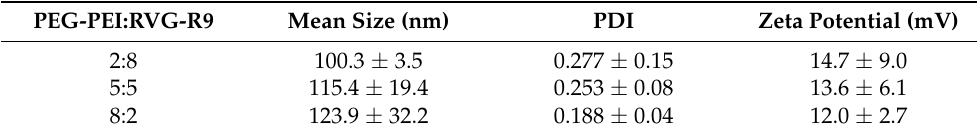
Table 2. Size and zeta potential of ternary complexes at the N/P ratio of 10.